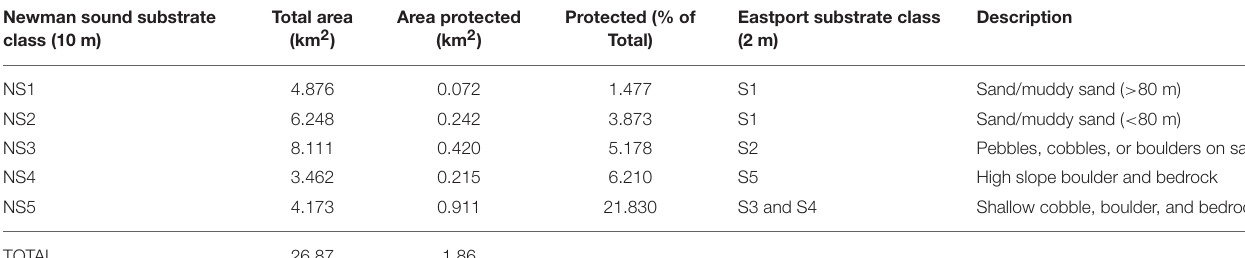
TABLE 3 | Representation of Newman Sound unsupervised substrate classes within Eastport MPA